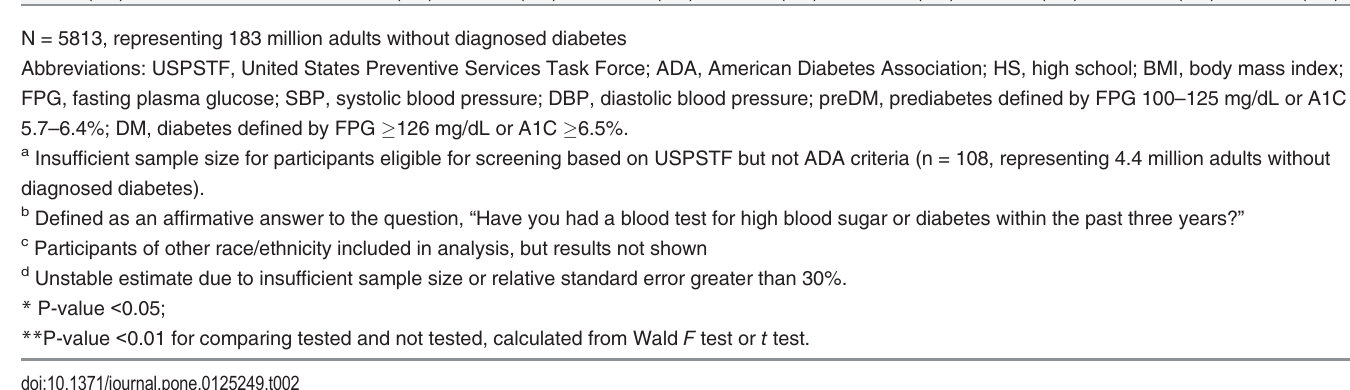
Total Eligible based on both Eligible based on ADA, Ineligible based on both ADA and USPSTF but not USPSTF ADA and USPSTF Currently recommended Potentially identi fi able Not recommended for for screening with new changes in 2015